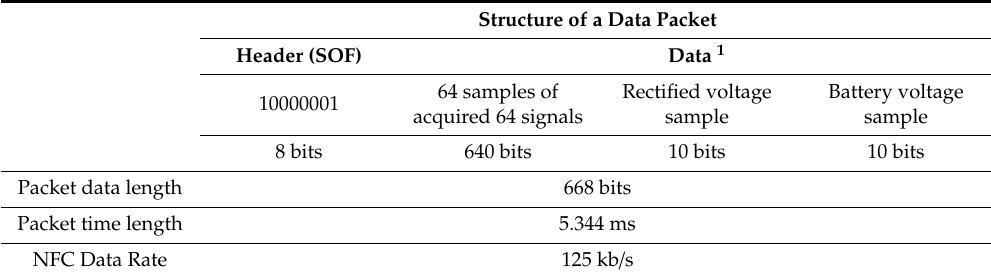
Table 1. Structure of the data packet to be encoded at the implantable